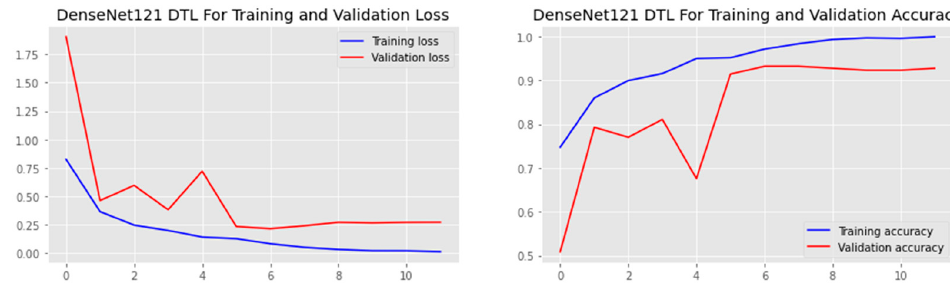
Figure 5. Accuracy and loss graph of the DenseNet121 model.